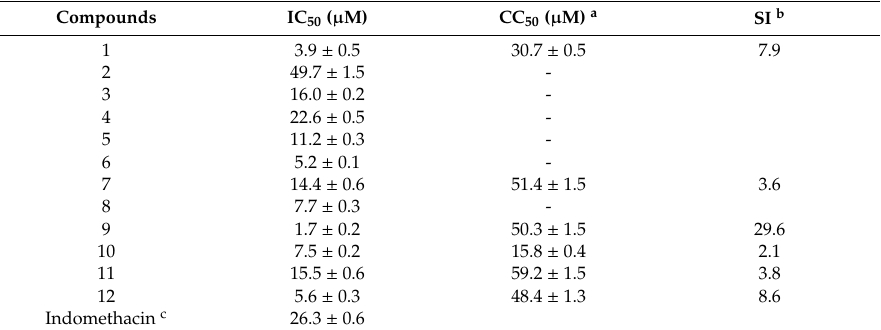
Table 2. Inhibitory activity of all compounds 1 − 12 against lipopolysaccharide (LPS)-induced NO production in the murine macrophage cell line (RAW 264.7 cells).